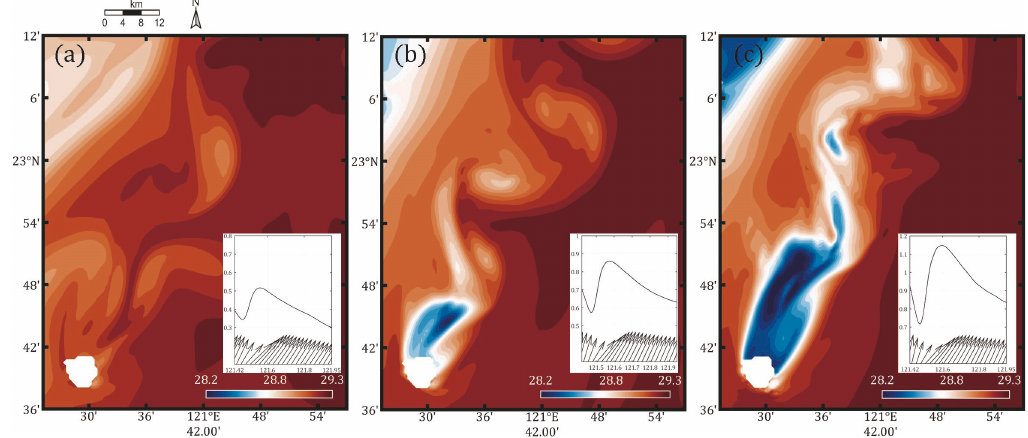
Figure 14. The island wake development from the MITgcm simulation for different Reynolds numbers. ( a ) Re = 70, ( b ) Re = 118, ( c ) Re = 156. The sub-image represents the change in speed (m/s) along 22.6° N.